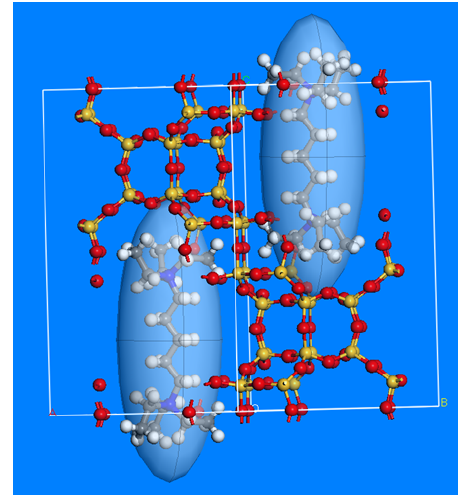
Figure 5. Computer simulated location of SDA molecules in UC of